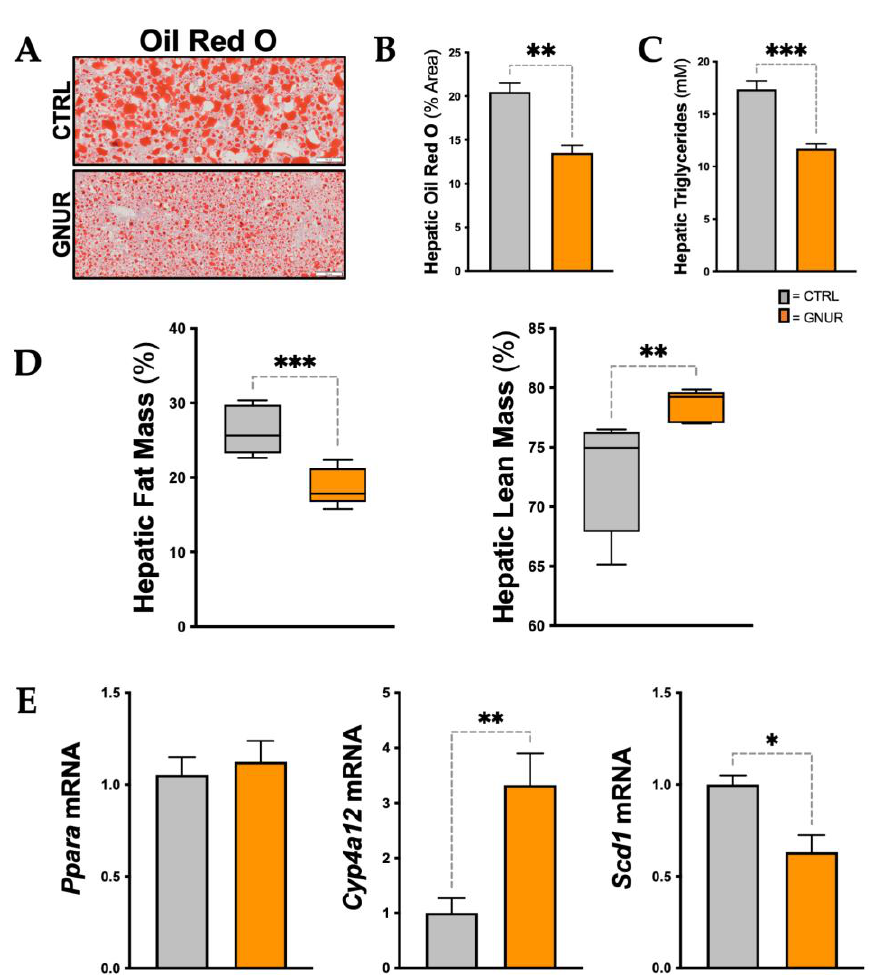
Figure 3. Hepatic lipid accumulation and PPARα signaling in the liver. ( A ) Oil Red O staining of the livers from GNUR- and CTRL-treated obese mice [scale bar = 100 μm], and ( B ) Oil Red O staining quantification [n = 4 for each group; **, p < 0.01]. ( C ) biochemical measurement of triglycerides